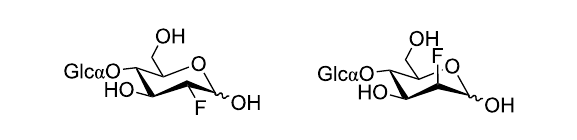
Figure 2: 2- 19 F-Maltose reporter system: Nonstereoselective fluorine labeling at the 2-position of maltose leads to a 2/1 mixture of two epimeric forms [left: gluco-type; right: manno-type]. Only the gluco-type isomer of 2-deoxy-2-fluoro-maltose retains the affinity to the maltose- binding protein